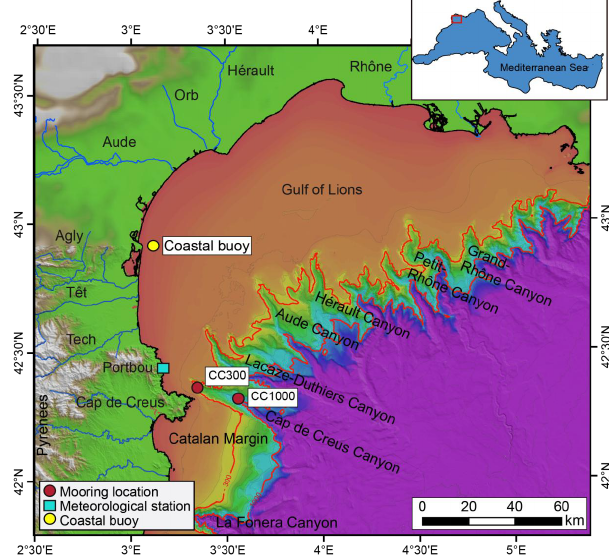
Fig. 1. Topo-bathymetric map of the Cap de Creus Canyon and neighboring areas: the northern Catalan margin at the South and the Gulf of Lions (northwestern Mediterranean) at the North. Locations of moorings (red dots), the meteorological station in Portbou (light blue square) and the Leucate coastal buoy (yellow dot) are shown. Top-right red square indicates where the heat fluxes and Chl- a concentration maps have been obtained. Bathymetric data published by Canals et al . (2004).